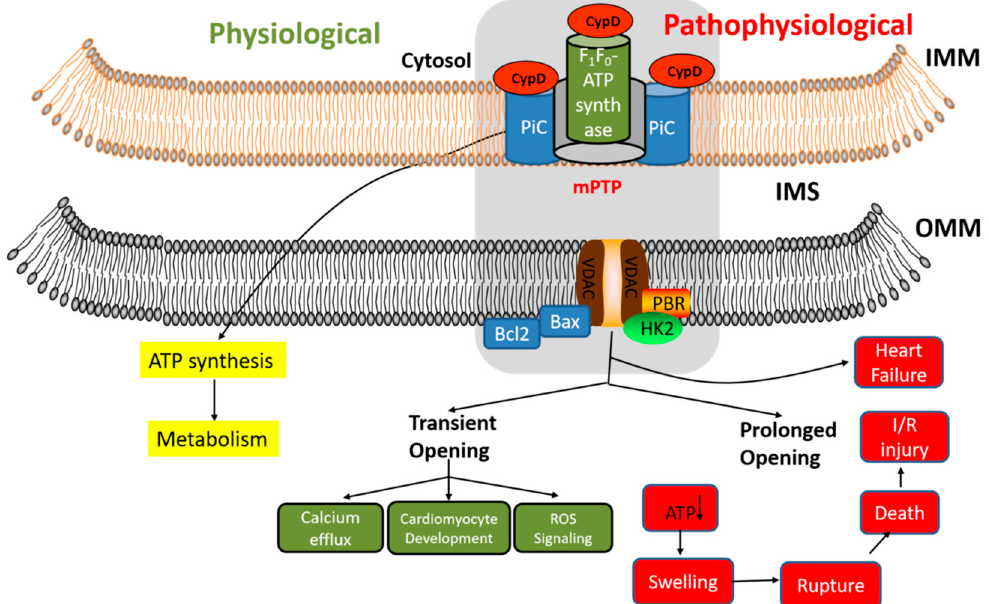
Figure 2. Dual role of mPTP in cardiac physiology and pathology. At the mitochondrial level, mPTP plays a dual role and participates in important physiological processes (ATP production and mitochondrial metabolism) and pathophysiological processes (cardiomyocyte death, heart failure, and I/R injury), while mCa 2+ overload leads to the opening of mPTP channels. mPTP is a large nonspecific pore of cardiomyocytes. It is a protein complex composed of many proteins, includ- ing F1F0-ATP synthase, cyclophilin D(CypD), the phosphate carrier (PiC) and voltage-dependent anion channel (VDAC) among others, that opens through the inner and outer membranes of mi- tochondria. VDAC is located in the outer membrane of mitochondria. The prolonged opening of mPTP leads to a reduction in ATP production, depolarization of the mitochondrial inner membrane, matrix swelling, rupture of the mitochondrial outer membrane, and cell death. Finally, it causes myocardial ischemia-reperfusion injury and heart failure. The transient opening of the mPTP channel causes calcium efflux, cardiomyocyte development, and ROS signal. IMS, intermembrane space; OMM, outer mitochondrial membrane; IMM, mitochondrial inner membrane. HK2, hexokinase 2; PBR, peripheral benzodiazepine receptor; I/R injury, ischemia-reperfusion injury. Importantly, Ca 2+ not only plays a key role in the regulation of cell death, but is also a critical sensitizing signal in mitochondrial pro-apoptotic transition [77]. Mitochondria are important checkpoints in the process of apoptosis, and they activate the internal pathways of apoptosis by releasing cytochrome C and other mitochondrial proteins into the